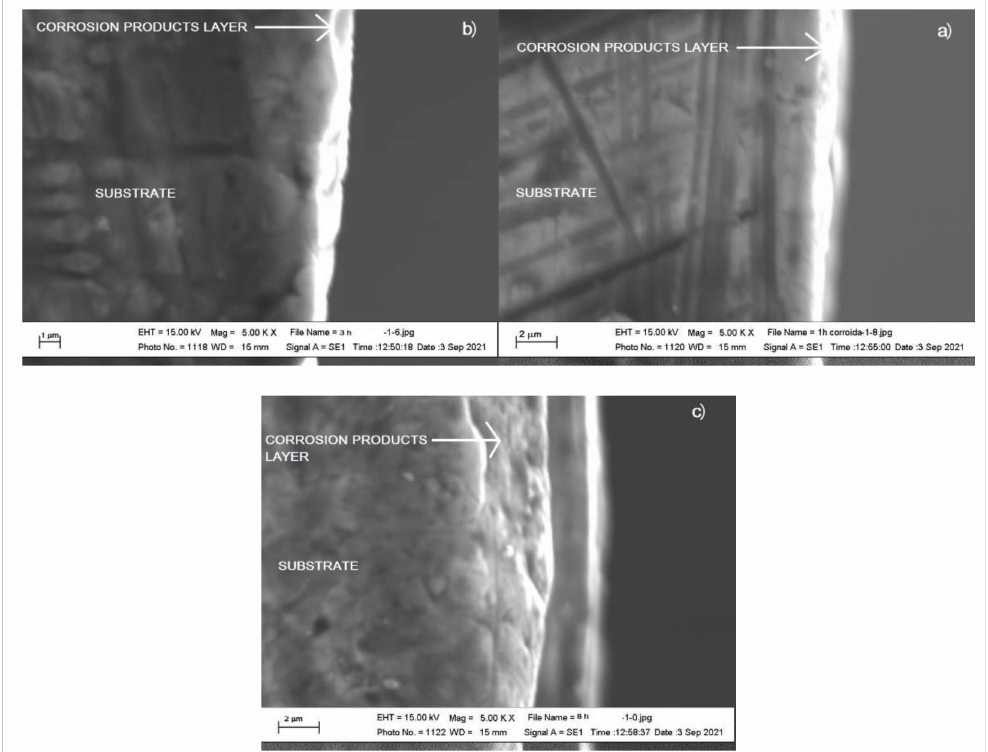
Figure 11. Cross section micrographs of Ti6Al4V alloy during ( a ) 1, ( b ) 3, and ( c ) 8 h and corroded in artificial saliva